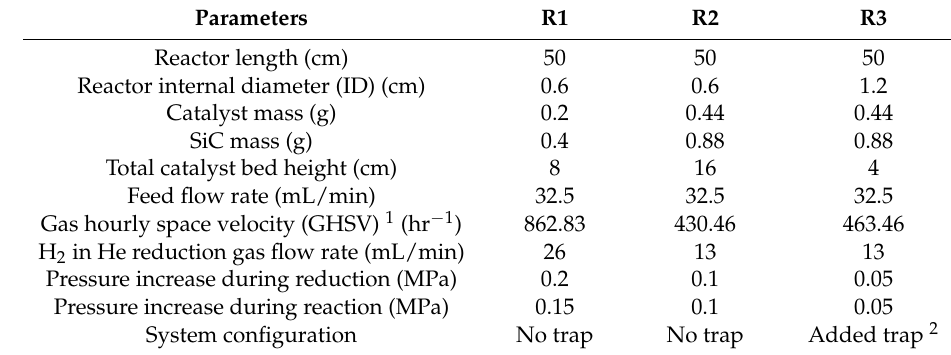
Table 2. Testing parameters for R1, R2, and